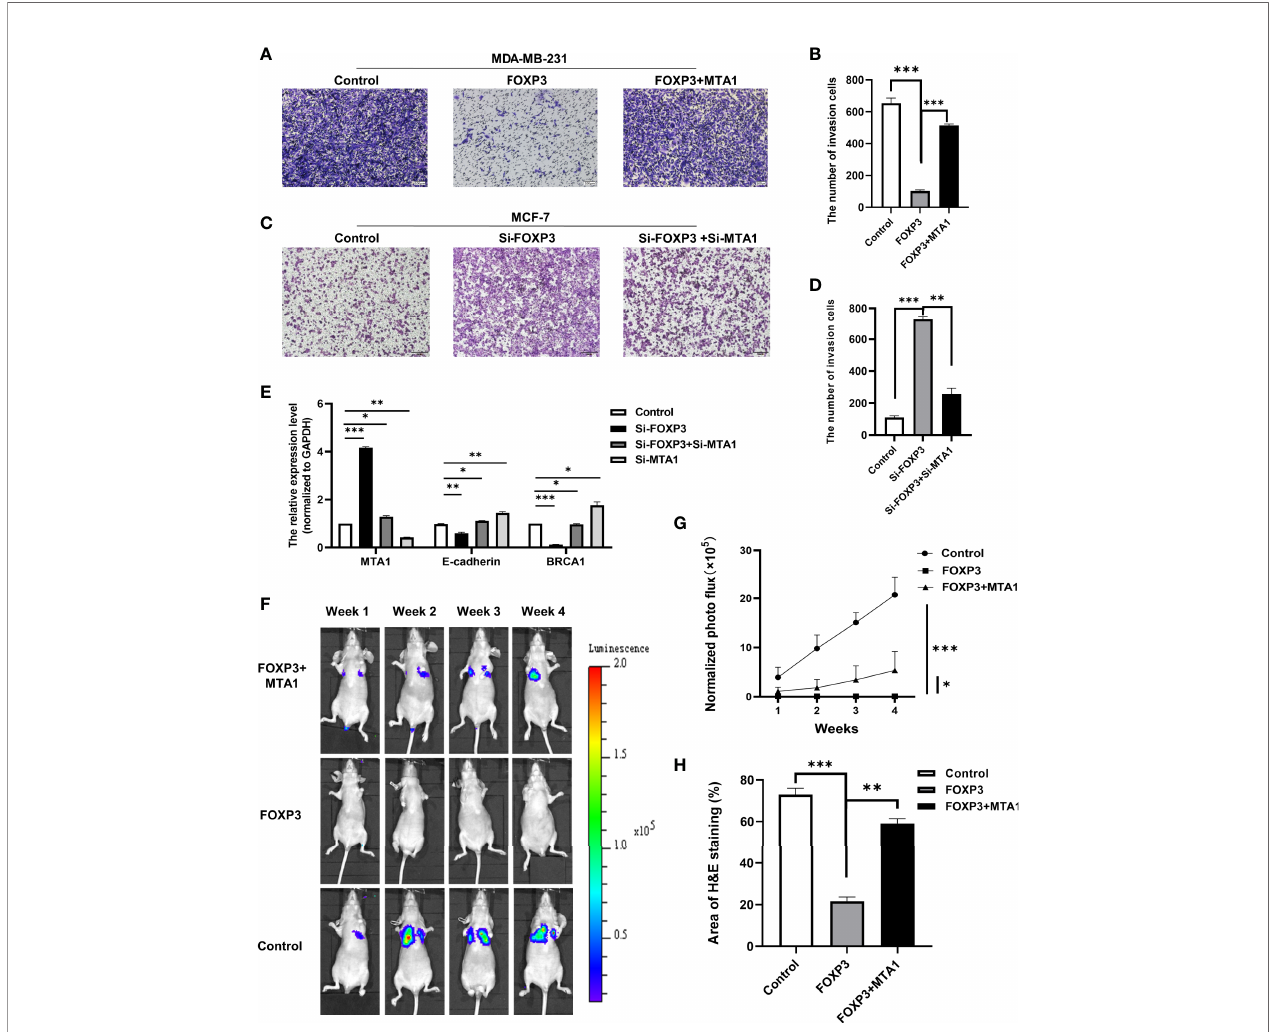
FIGURE 3 | The FOXP3-MTA1 pathway regulates the invasion and migration of breast cancer cells in vitro and in vivo . Transwell assays were used to examine the invasion abilities of MDA-MB-231 cells (A) and MCF-7 cells (C) . (B, D) Statistical analysis of the experimental data in (A, C) respectively. (E) The mRNA expression levels of potential downstream molecules were determined. (F) , In vivo imaging technology was used to demonstrate that FOXP3 can affect the ability of breast cancer cells to metastasize in vivo by regulating MTA1. (G) Statistical analysis of fl uorescence values in (F) . (H) H&E staining showed that FOXP3 inhibited lung metastasis from breast cancer by regulating MTA1 expression. The data are shown as the mean ± s.e.m. ns, P > 0.05; *P < 0.05; **P < 0.01; and ***P <